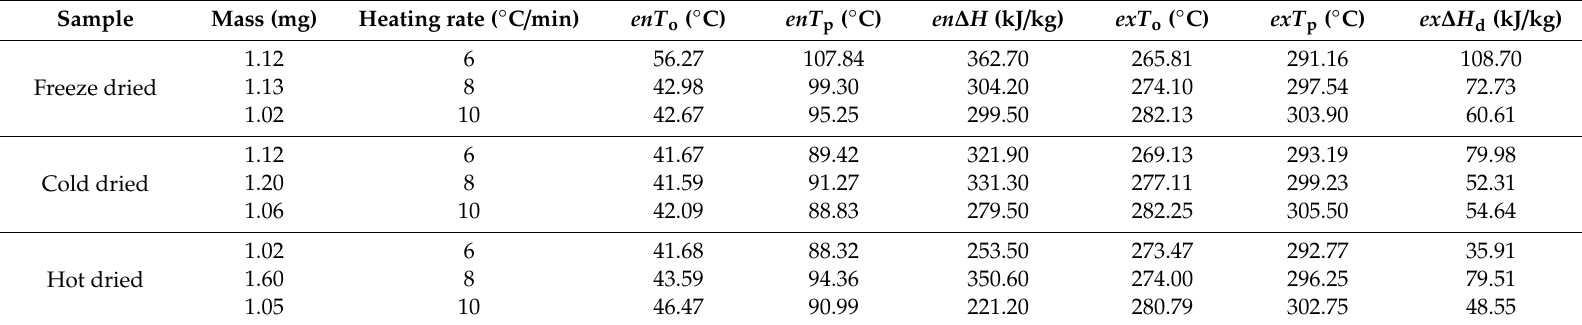
Table 3. Results of di ff erential scanning calorimetry (DSC) tests of various drying processes with scanning rates of 6, 8, and 10 ◦ C / min in a temperature rise range chosen from 30 to 450 ◦